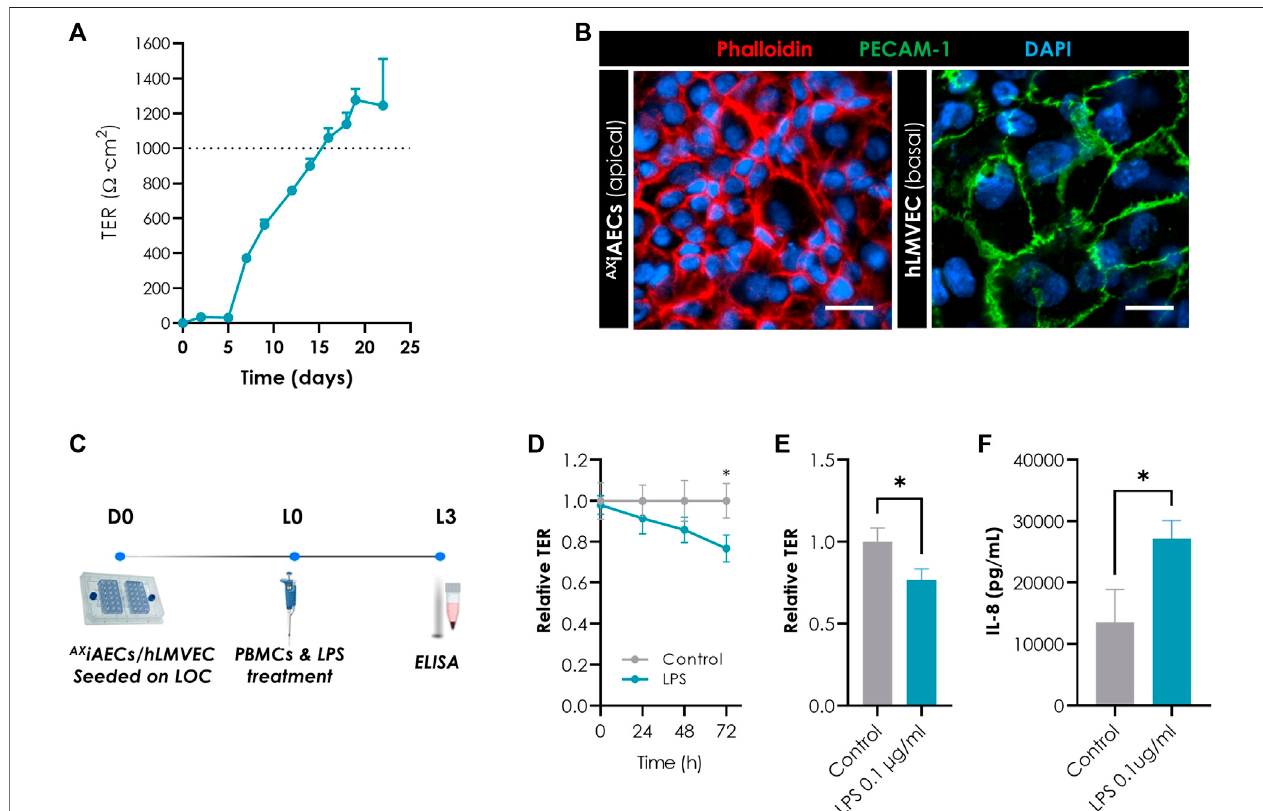
FIGURE7| LPS-inducedin fl ammationin AX iAECs/hLMVECco-cultureon-chip. (A) TERvaluesabove1,000 Ω cm 2 (dottedline)wererecordedfromday16(N=4, n = 42). (B) Representative image of AX iAECs/hLMVEC co-culture stained with phalloidin (red) and PECAM-1 (green). Nuclei were stained with DAPI (blue). Scale bar is 20 µm. (C) Timeline and schematic of LPS treatment on day L0 in AX iAECs/hLMVECs/PBMCs. Cells were harvested 72 h after stimulation with 0.1 μ g/ml LPS (L3). (D) Signi fi cantreductiononTERvalues(relativetoL0andcontrolconditions)recordedondayL3aftertreatmentwithLPS(control,N=3; n =7;LPStreated:N=3; n = 9). (E) IL-8secretionfromcontrol(untreated)andLPS(0.1 μ g/ml)treatedcellsweredeterminedbyELISAonL3(control,N=3; n =6;LPS,N=3; n =7). (F) IL-8secretion from control (untreated) and LPS (0.1 μ g/ml) treated cells were determined by ELISA on L3 (control,N = 3; n = 6; LPS, N = 3; n = 7). Data shown as mean ± SEM, * p < 0.05, ** p < 0.01, *** p < 0.001.